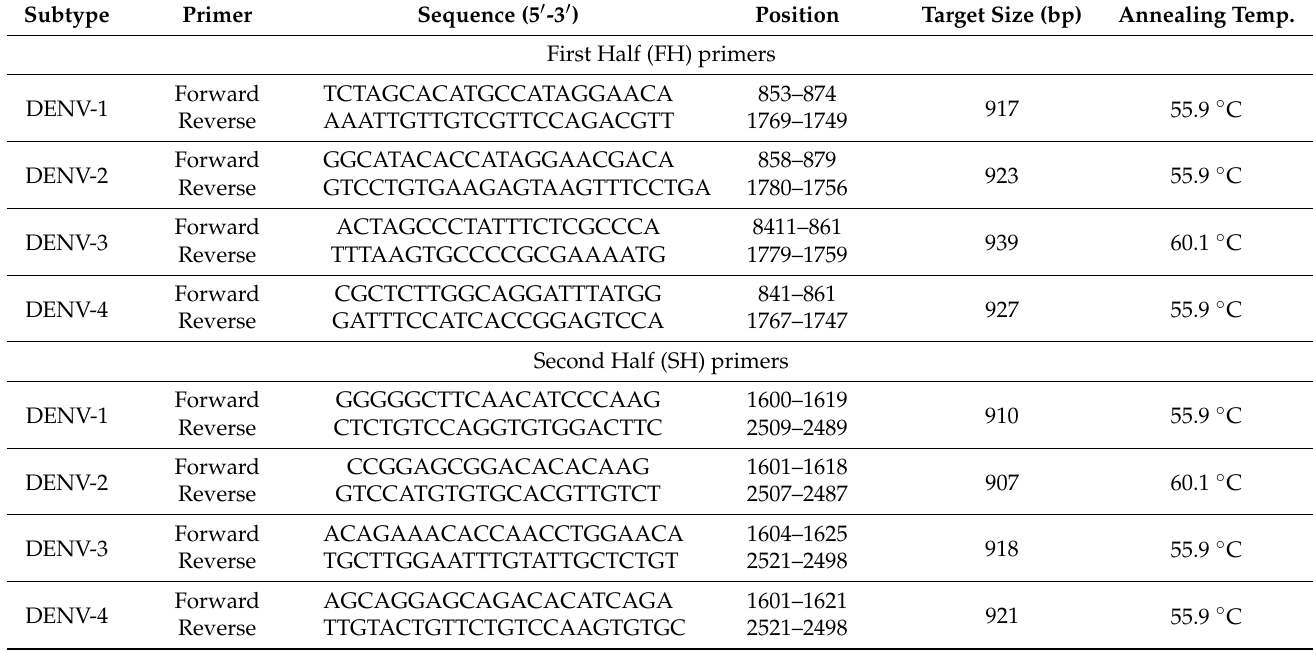
Table 1. Primer sequences and Annealing Temperatures of DENV 1-4 envelope